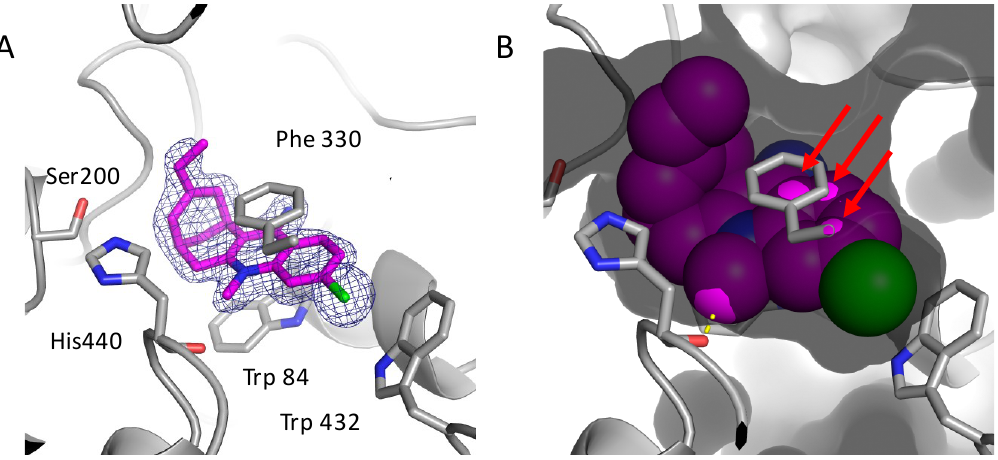
Figure 4. Binding of 6 to Tc AChE. ( A ) 2mFO-DFc map, contoured at 1 σ, of 6 within the active site of Tc AChE. Clear electron density is observed for the extra methyl group of 6 ; ( B ) 6 is depicted in space-filling format, and the gorge surface is shown in gray. A close contact is observed with the carbonyl group of His440 (yellow dashed line). Introduction of the methyl group also resulted in reorientation of some atoms of 6 that are in close proximity to Phe330 (red arrows in panel ( B )).